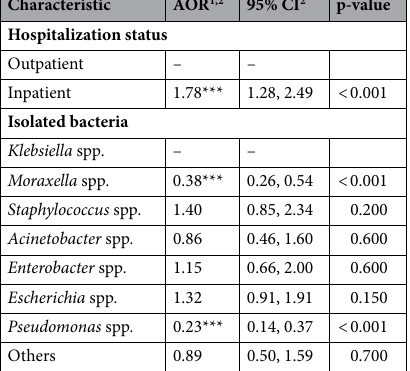
Table 6. Multivariable logistic regression of factors associated with multidrug resistance. 1 *p < 0.05; **p < 0.01; ***p < 0.001; 2 AOR adjusted odds ratio, CI confidence